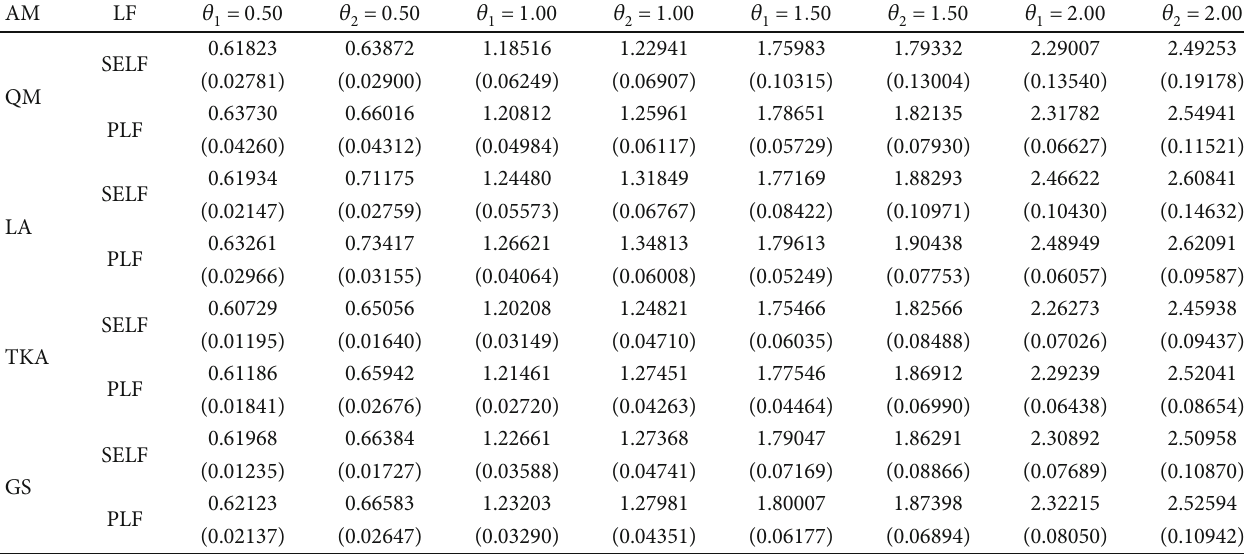
Table 2: BEs and PRs (in parenthesis) under IP for n = 30 .